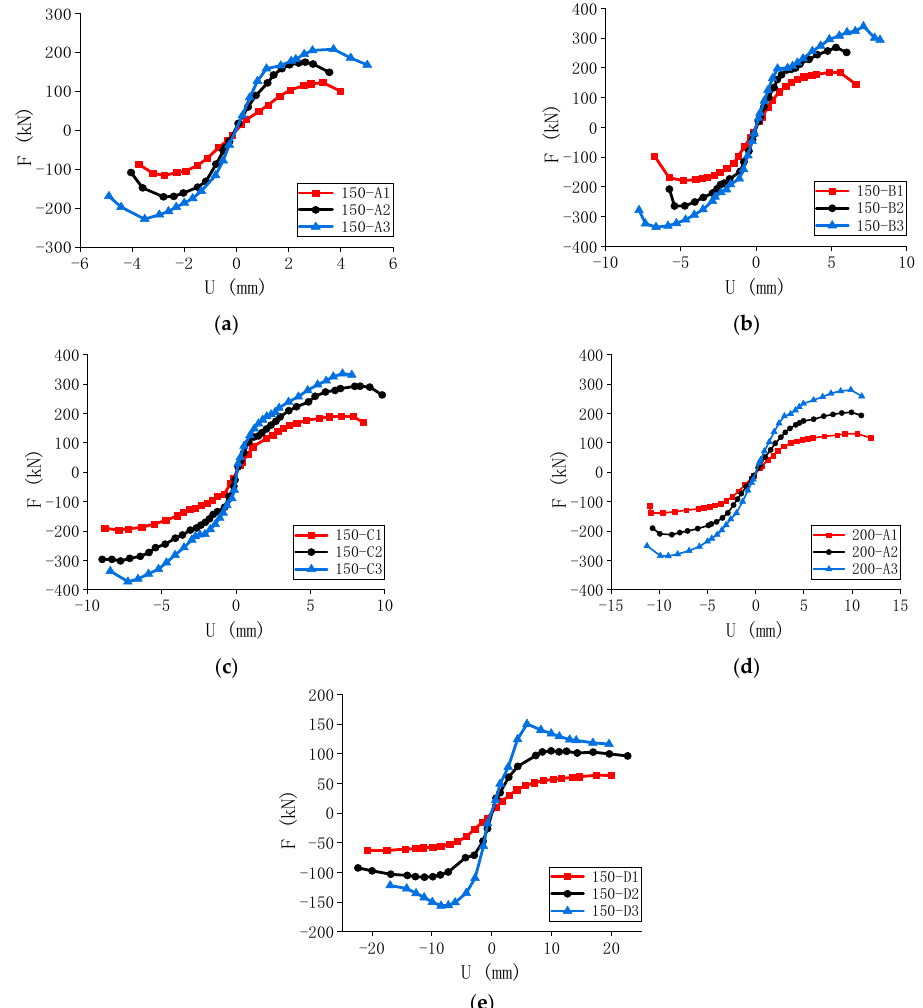
Figure 10. Skeleton curves of the specimens ( a ) 150 ‐ A, 150 ‐ A2, and 150 ‐ A3; ( b ) 150 ‐ B1, 150 ‐ B2, and 150 ‐ B3; ( c ) 150 ‐ C1, 150 ‐ C2, and 150 ‐ C3; ( d ) 200 ‐ A1, 200 ‐ A2, and 200 ‐ A3; ( e ) 150 ‐ D1, 150 ‐ D2, and 150 ‐ D3.